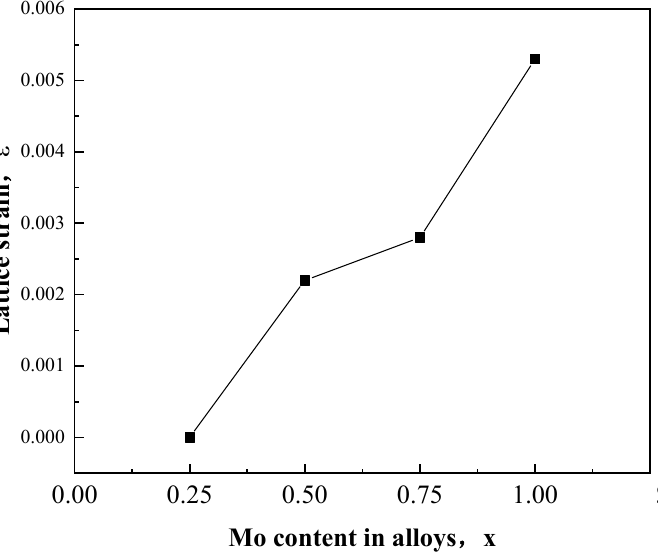
Figure 2. Lattice strain of FCC phase as a function of Mo content in CoFeNiMnMo x ( x = 0.25, 0.5, 0.75 and 1.0) alloys.